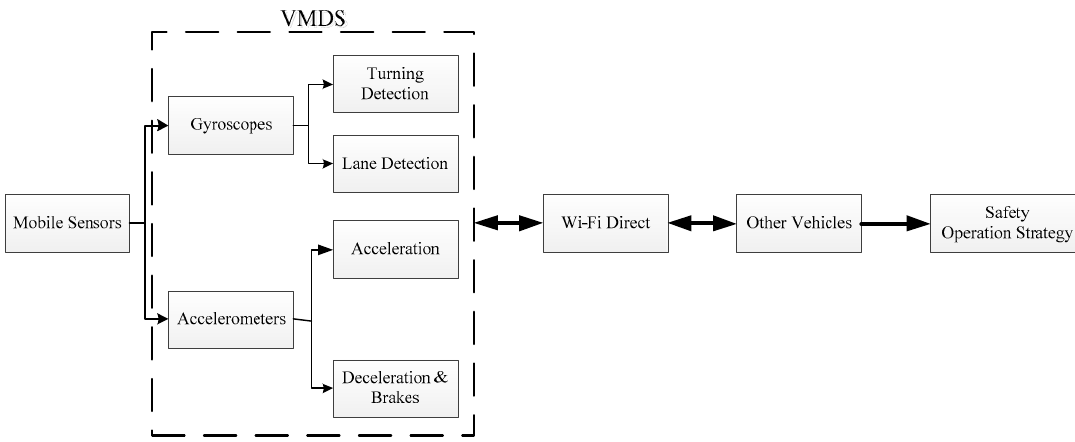
Figure 1. Overview vision for the vehicle motion detection system (VMDS) and outlines of this study. Our contribution in this paper is specified as follows.